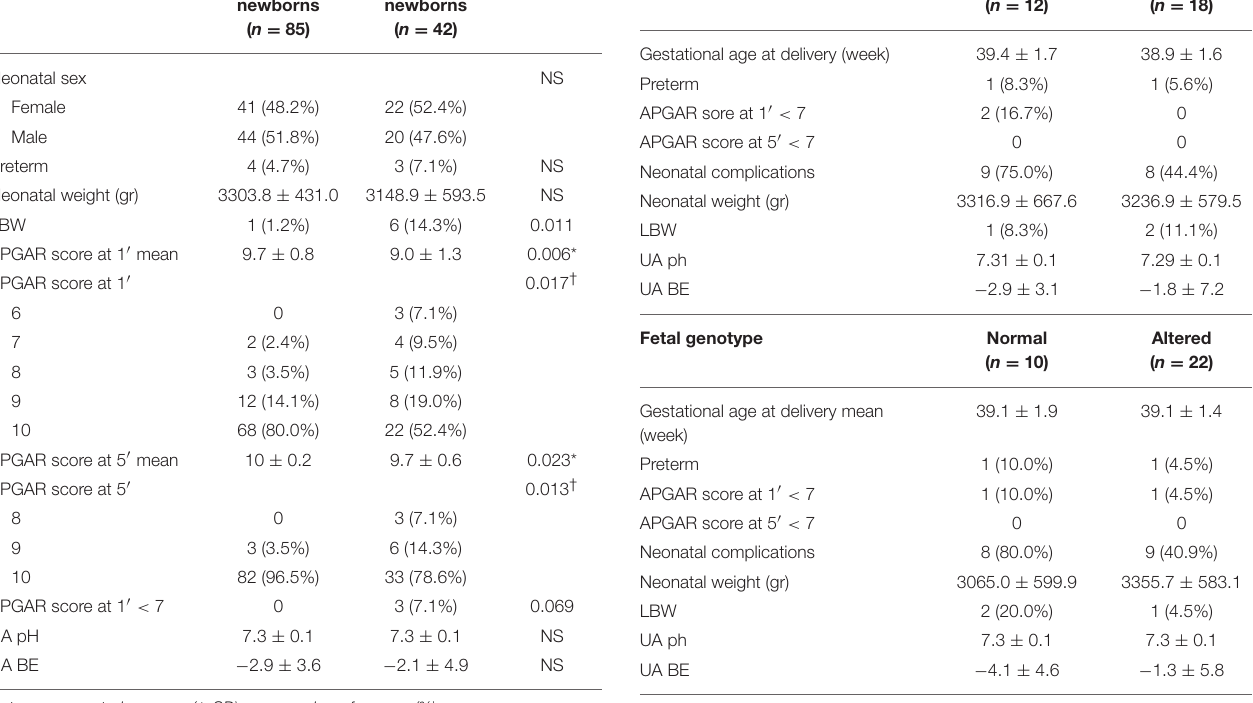
TABLE 3 | Neonatal outcomes. TABLE 4 | Neonatal outcomes considering maternal and fetal genotype. Maternal